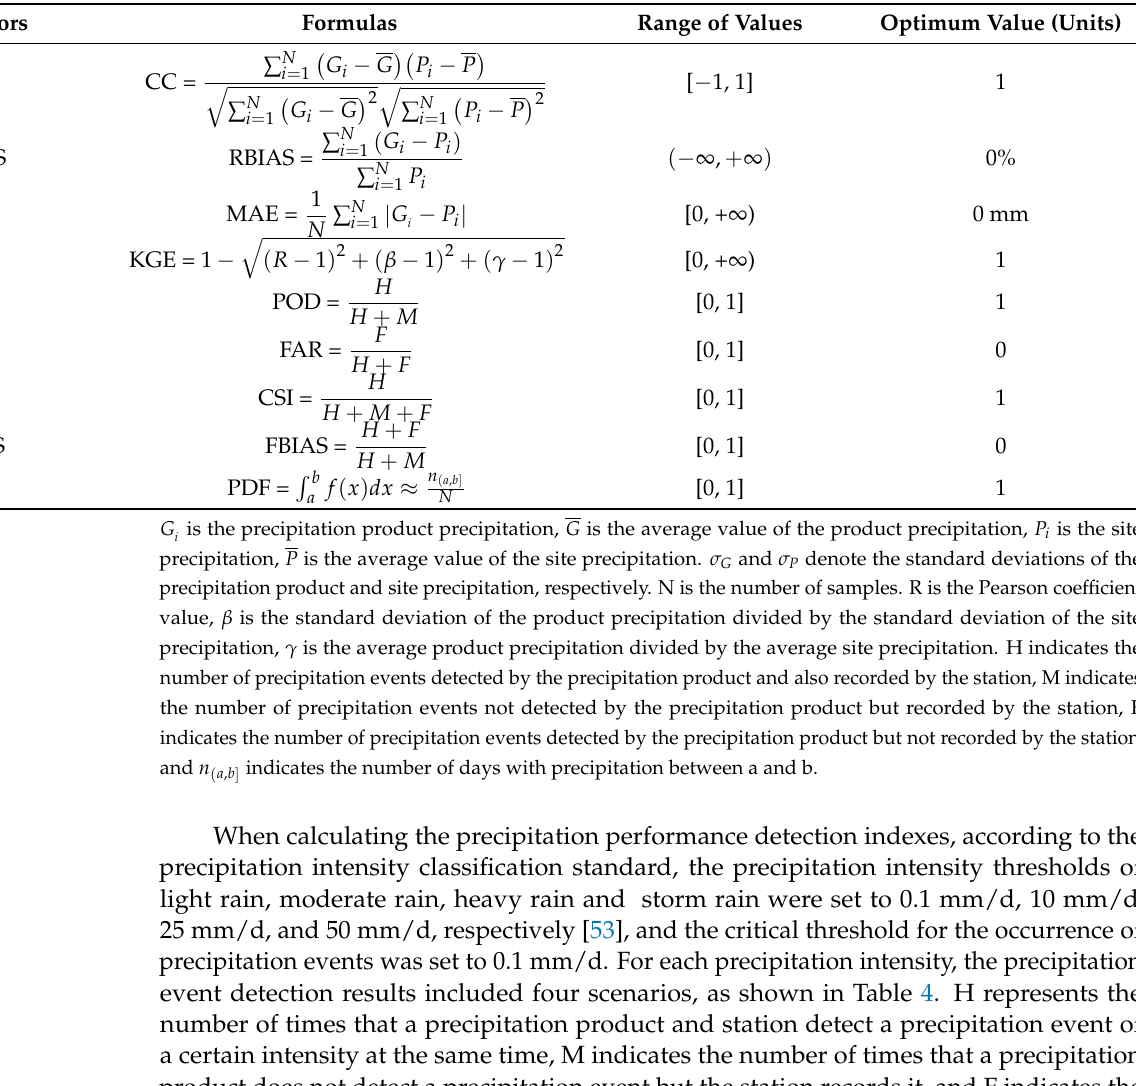
Table 3. Statistical